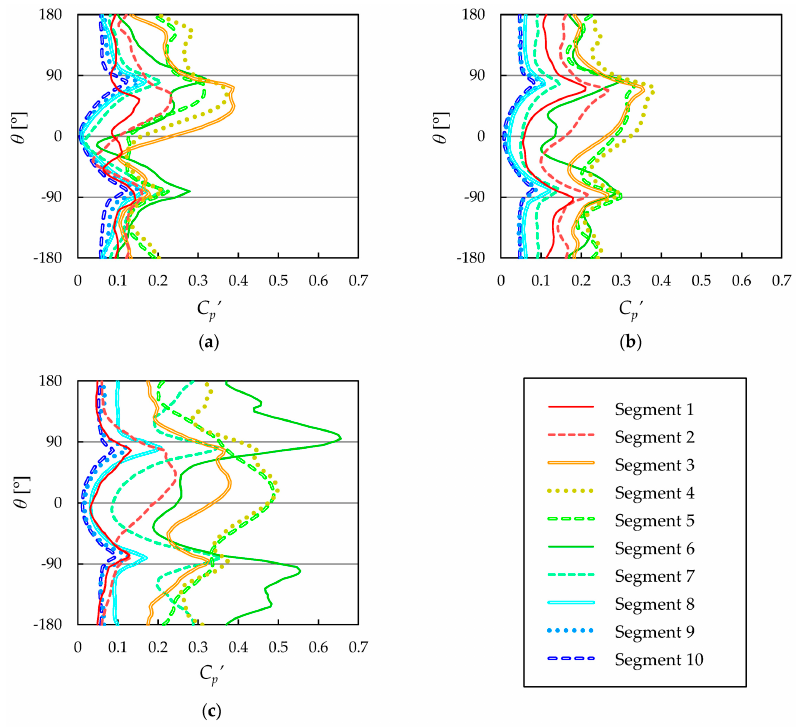
Figure 10. Distributions of the fluctuating pressure coefficient on the tower surface at the mid-heights of each tower segment. ( a ) λ = 3; ( b ) λ = 6; and ( c ) λ = 10.